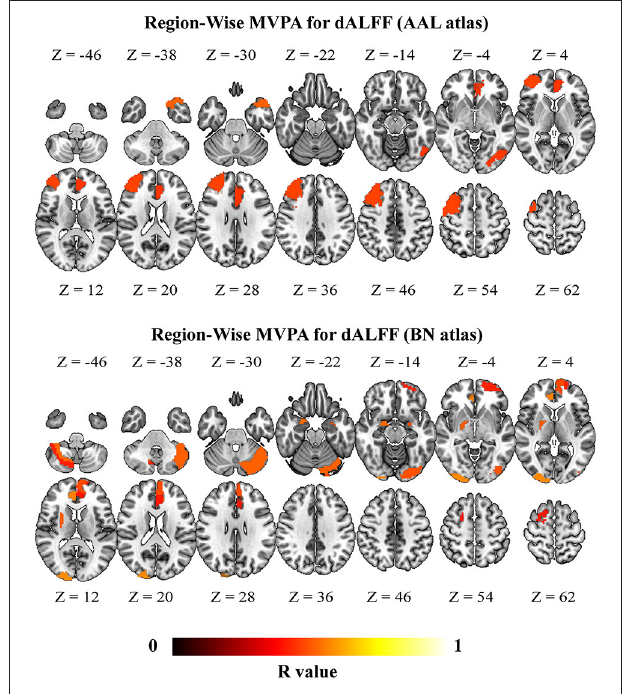
FIGURE 7 | Brain regions with significant correlation coefficients in the prediction of JOA recovery rate using the dynamic amplitude of low-frequency fluctuation (dALFF) ( p < 0.05, FWE for multiple comparison correction). DCM, Degenerative Cervical Myelopathy; HC, Healthy Controls; AAL, Anatomical Automatic Labeling; BN,